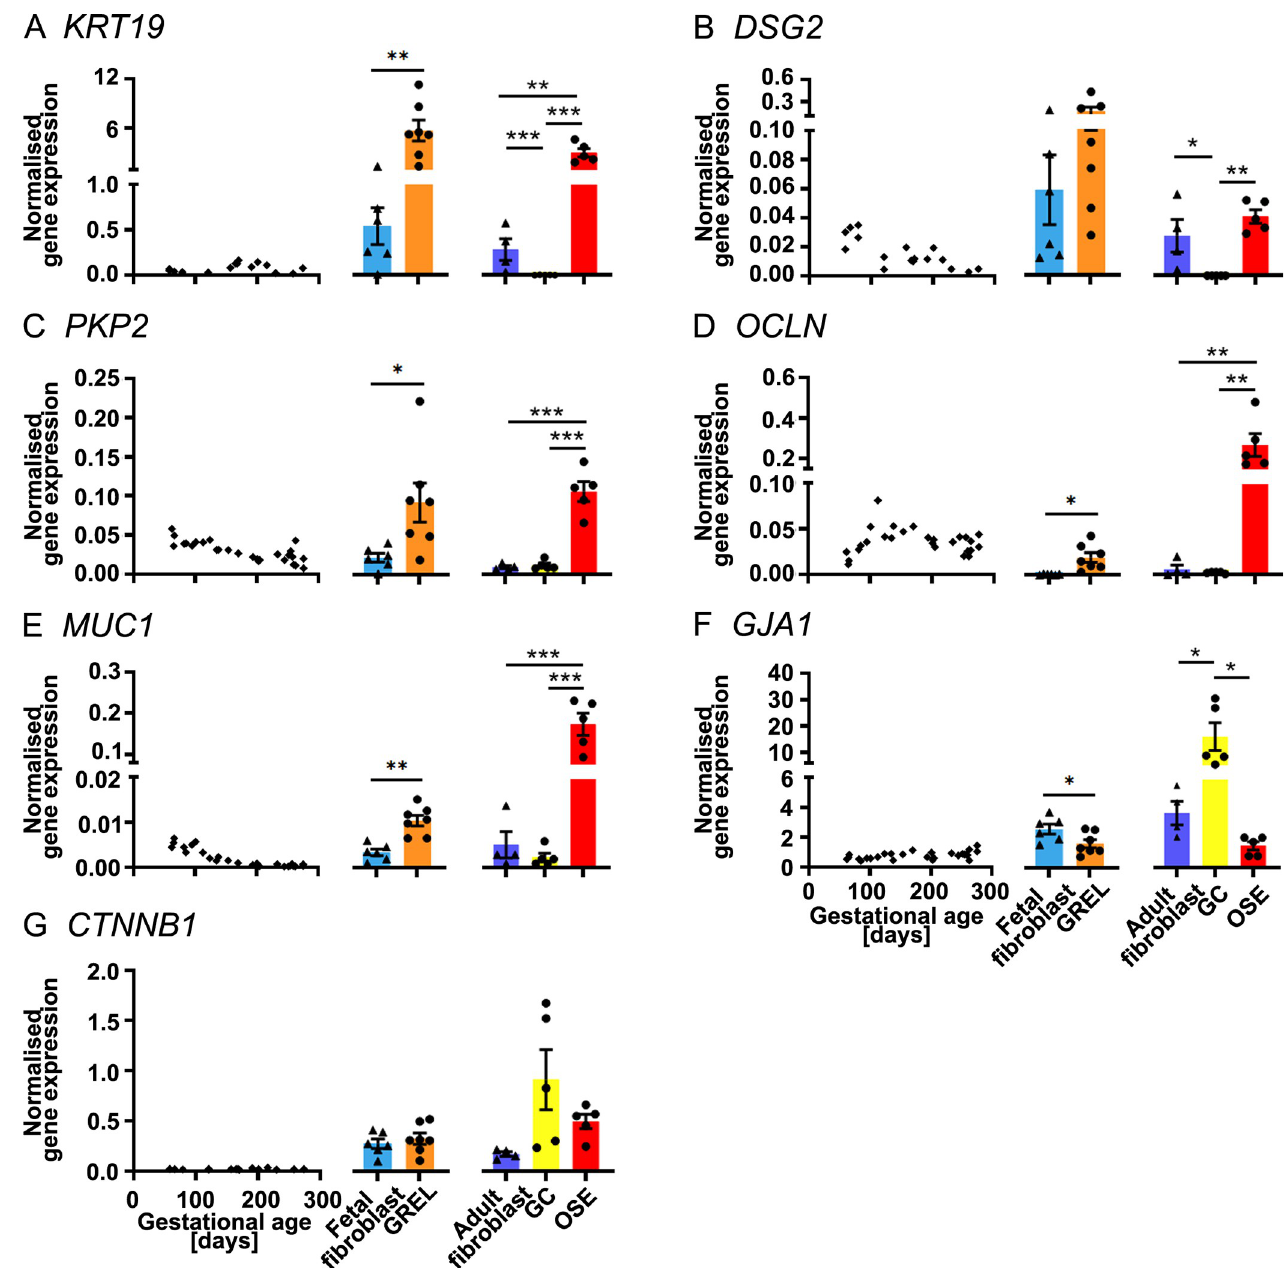
Fig 2. mRNA expression levels of genes associated with cellular junctions. Scatter plots in each subfigure show gene expression levels in fetal ovaries at different gestational ages (n = 27), and scatter plots for KRT19 (A), DSG2 (B) and CTNNB1 (G) are from our previous publications [30, 31]. Gene expression levels in cultured GREL cells (n = 7; gestational ages are 51, 56, 73, 110, 110, 127 and 177 days) and fetal fibroblasts (n = 6; gestational ages are 51, 73, 101, 110, 110 and 177 days) are presented as mean ± SEM (normalised to PPIA and RPL32 ) in the middle graph of each subfigure. The differences between GREL cells and fetal fibroblasts were analysed with Student’s t-test. Data of gene expression in adult fibroblasts (n = 4), granulosa cells (GC; n = 5) and ovarian surface epithelium (OSE; n = 5) are presented as mean ± SEM (normalised to PPIA and RPL32 ) in the graph on the right side of each subfigure. Significant differences among the three adult cell types were determined by one-way ANOVA with Tukey’s post-hoc test. � P < 0.05, �� P < 0.01, ��� P <